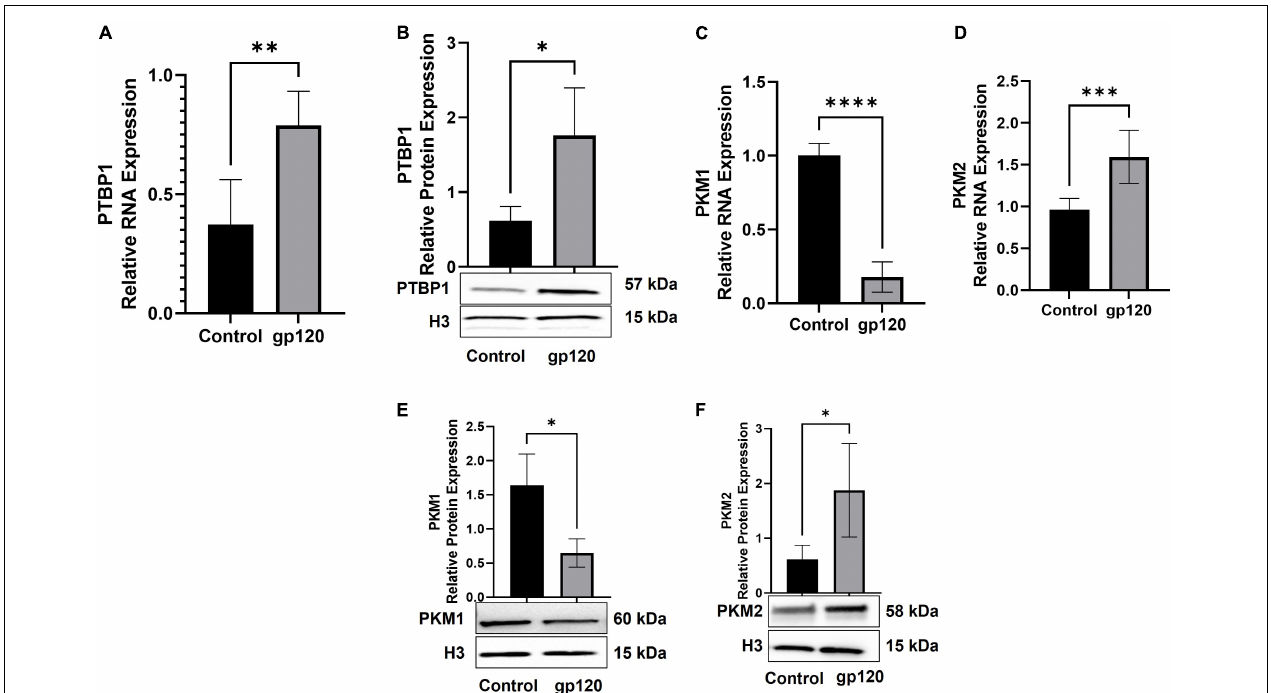
FIGURE 6 | Changes in proteins responsible for metabolic reprogramming. Expression of PTBP1 (A,B) , PKM1 (C,E) , and PKM2 (D,F) mRNA and protein isolated from untreated or gp120-treated LUHMES for 8 h as obtained by qPCR and normalized to GAPDH as an internal control (A,C,D) and Western blot (B,E,F) , respectively. Quantification of the relative protein levels was determined from the band intensity using ImageJ software and normalized relative to the H3. Bar graphs represent means ± S.D. Data represent the mean ± S.D. Results were judged statistically significant by ANOVA ( ∗ p < 0.05, ∗∗ p < 0.01, ∗∗∗ p < 0.001, **** p <